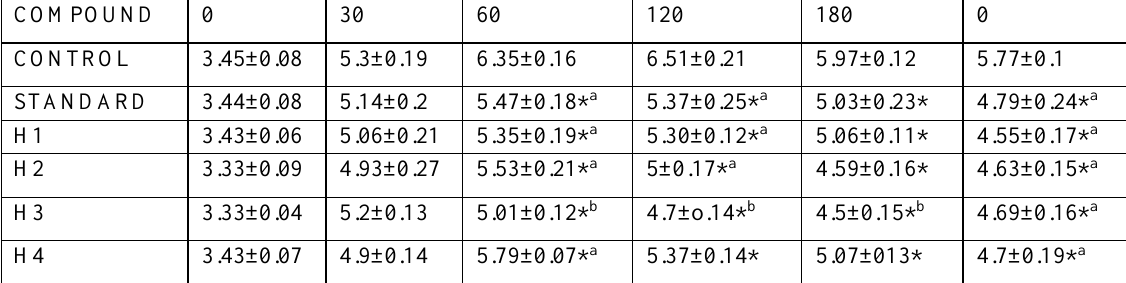
Table 1. Effect of dimethyl sulfoxide (control), Fenoprofen(standard) and target compounds (H1-H4) on egg-white induced paw